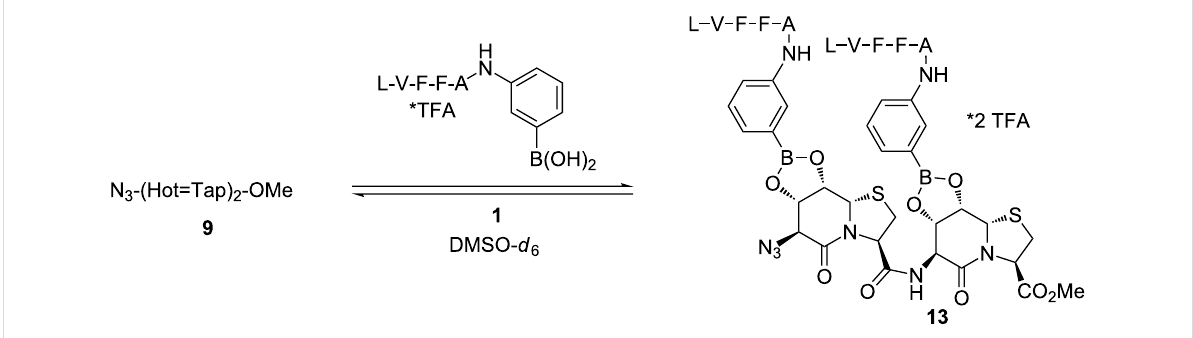
Figure 7: Template 9 (2.30 mg, 4.40 µmol, 1.0 equiv) and peptide boronic acid 1 (7.35 mg, 8.80 µmol, 2.0 equiv) were dissolved in 0.7 mL DMSO- d 6 in a NMR tube. A ratio of 9 /C-terminal monoester/N-terminal monoester/ 13 (0.04:0.24:0.08:0.60) was observed in the presence of 5.5 equiv of water.